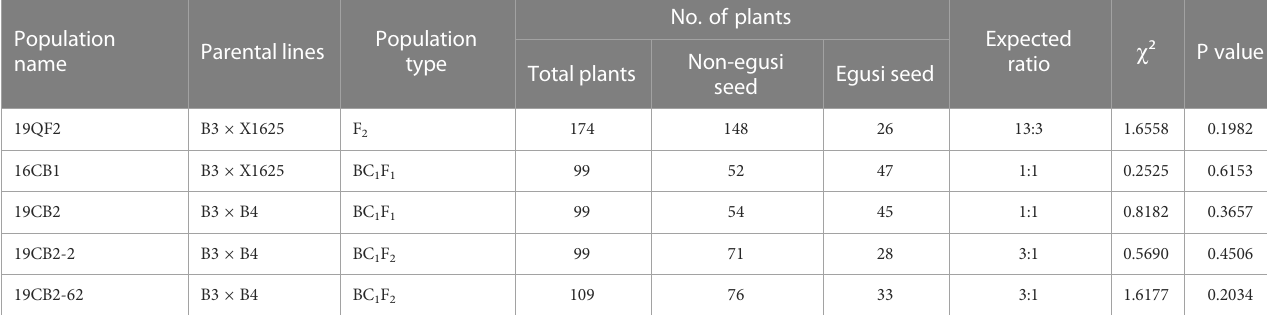
TABLE 1 Segregation ratio of plants with non-egusi and egusi seeds in different populations.